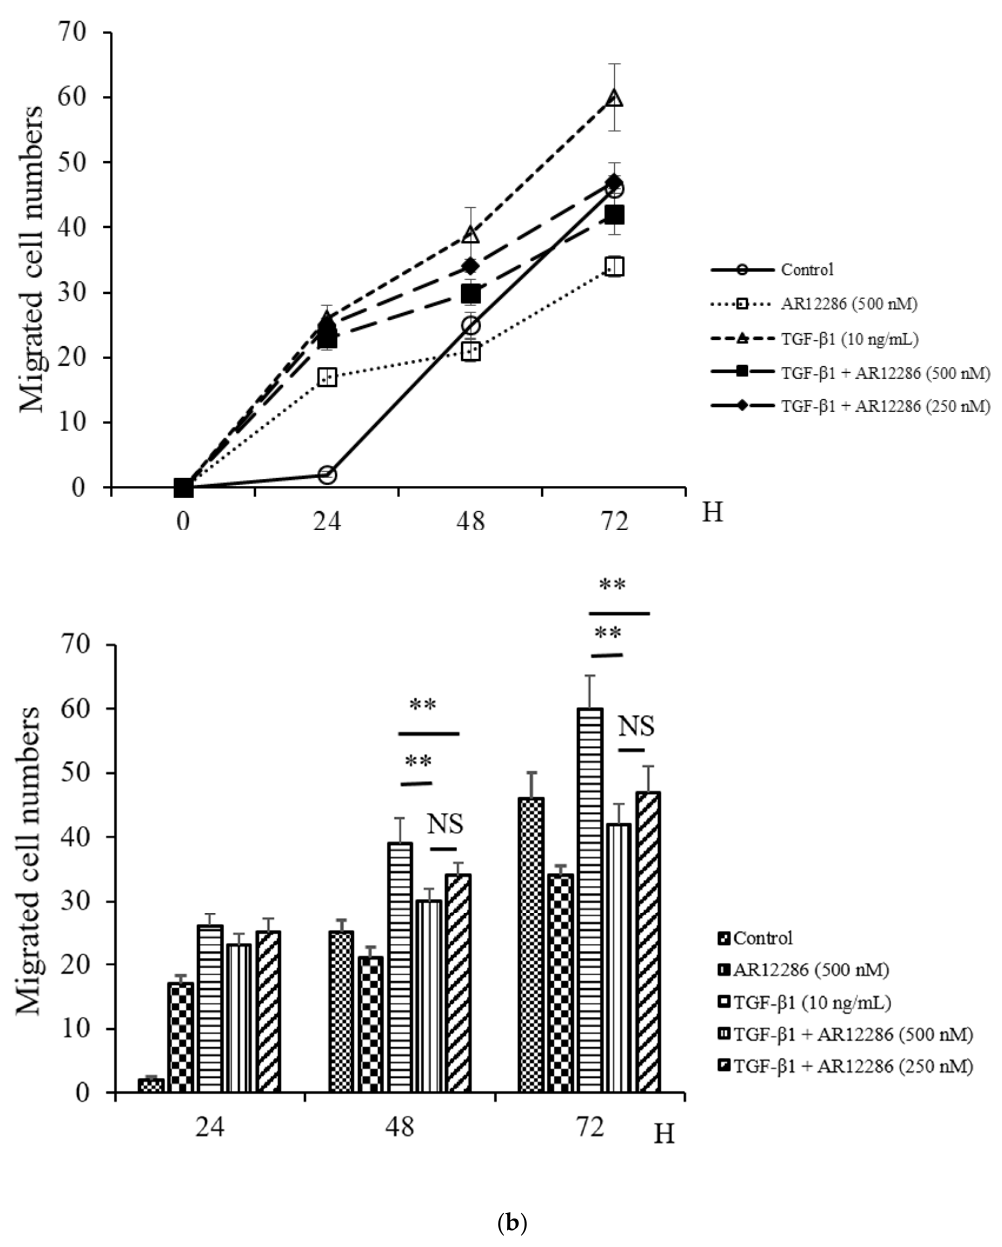
Figure 4. Cell migration inhibited by AR12286. Cell-free linear wound presented when confluent cultures were scraped with a pipette tip. Medium was individually replaced with fresh cultured medium in the following cultures: control, TGF- β 1-induced, AR12286-treated, TGF- β 1-induced with 250 nM treatment of AR12286, and TGF- β 1-induced with 500 nM treatment of AR12286. ( a ) Cell migration into the wound area photographed after incubation for 24, 48, and 72 h; ( b ) number of migrated cells was determined. Dotted lines, edges of migrated cells. All data expressed as means ± SEM ( n = 6). Asterisks indicate significantly different responses (**, p < 0.01), and NS signifies no significant difference.